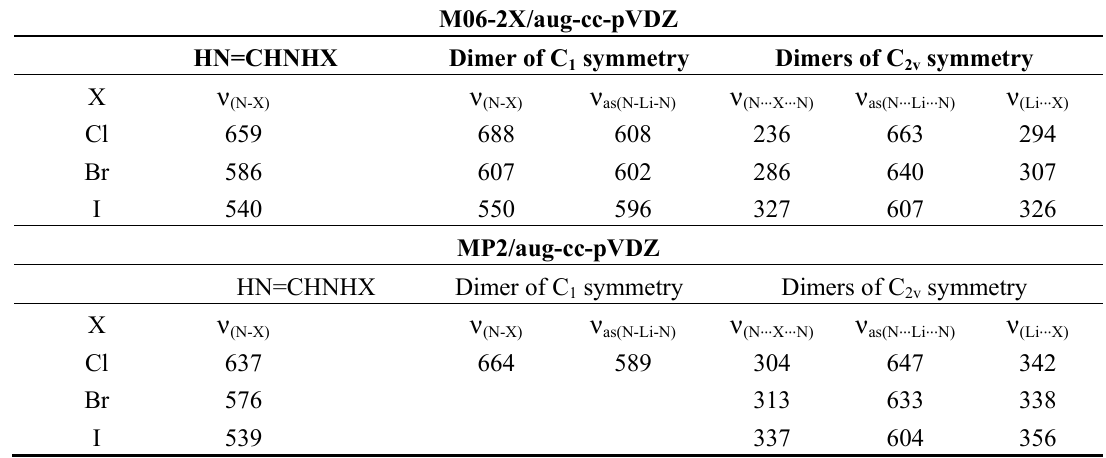
Table 3. Selected stretching (cm − 1 ) frequencies for HN=CHNHX and their dimers with CH(NH 2